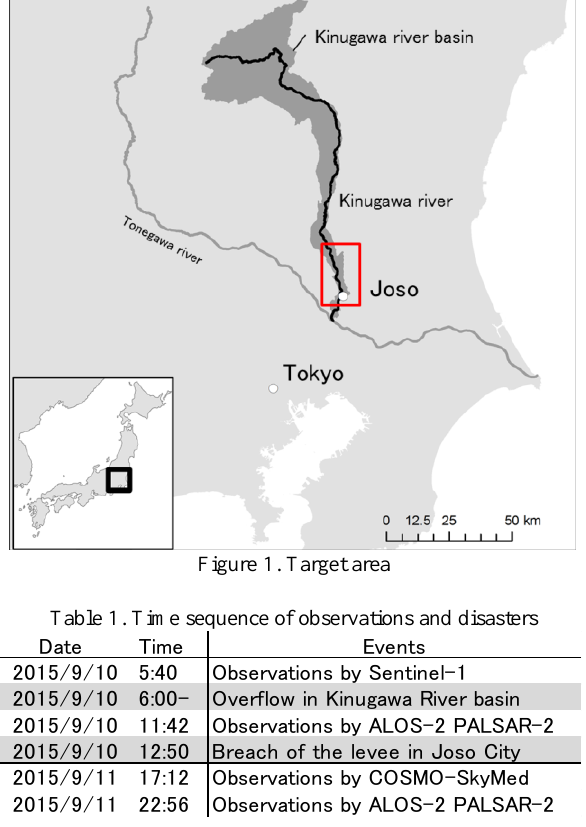
Table 2. Data specifications for SAR satellites used Obs. Date Orbit